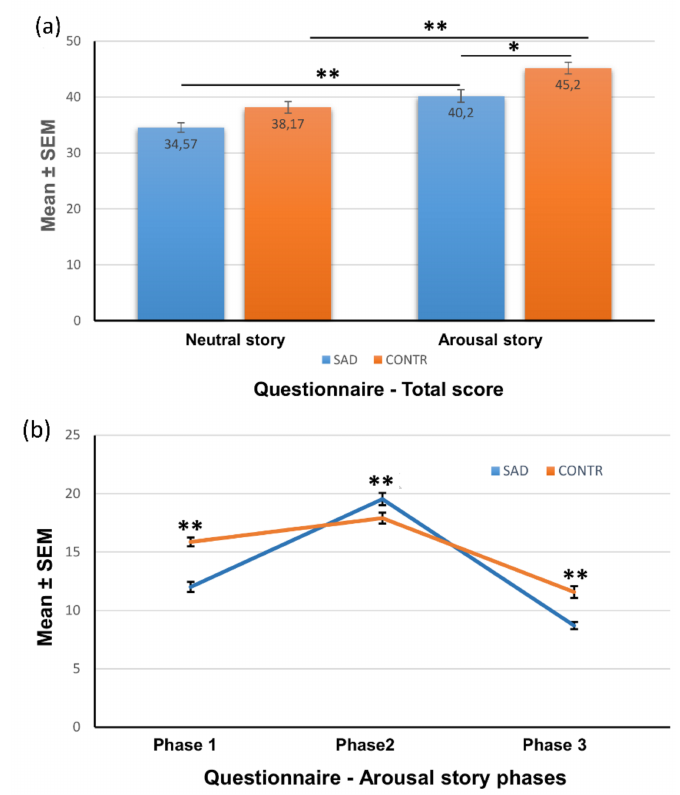
Figure 4. Recognition memory score. ( a ) Total score (mean ± SEM) of the questionnaire of the subjects assigned to the neutral and arousal conditions. * p < 0.01; ** p < 0.001. ( b ) Questionnaire scores (mean ± SEM) for each phase of the story of the subjects assigned to the arousal condition. * p < 0.05; ** p <